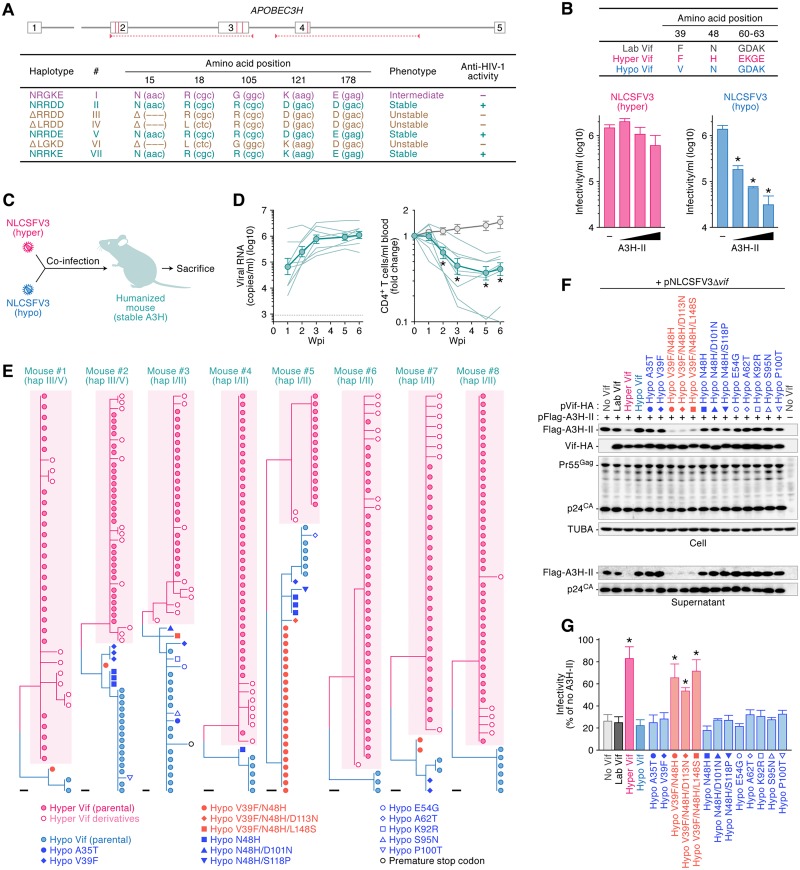
Dynamics of hyper/hypo HIV-1 infection in stable A3H humanized mice.(A) A schematic of the A3H gene locus and the 5 polymorphisms in A3H exons 2, 3, and 4 (indicated by red vertical lines) that combine to produce 7 different haplotypes. Red arrowheads with horizontal broken lines indicate the region amplified by genotyping PCR. In the bottom panel, the 7 different A3H haplotypes based on observed protein stability or instability in previous studies [14,15,20] are summarized. (B) (top) A schematic of the Vif protein encoded by HIV-1 used in this study. This panel shows the amino acid differences responsible for the degradation of stable A3H. (bottom) TZM-bl assay. The infectivity of released virions was determined by using TZM-bl cells. *P < 0.05 versus no A3H-II by Student's t test. The assay was performed in triplicate. The data represents average with SD. (C, D) HIV-1 infection in humanized mice. (C) A schematic of co-inoculation of hyper and hypo HIV-1s into stable A3H humanized mice. (D) Hyper and hypo viruses containing 2.5 ng of p24 antigen each (5 ng in total; n = 8) or RPMI1640 (n = 12; for mock infection) were inoculated into humanized mice. the amount of viral RNA in plasma (left) and the level of peripheral CD4+ T cells (CD45+ CD3+ CD4+ cells) (right) were analyzed at 0, 1, 2, 3, 5, and 6 wpi as described in Materials and Methods. The averages are shown in circles with SEMs, and the values from each mouse are shown by line. X-axes, wpi. In the left panel, horizontal broken line indicates detection limit (800 copies/ml plasma). In the right panel, *P < 0.05 versus mock-infected mice by Mann-Whitney U test. (E) Phylogenetic trees of vif sequence. Viral vif sequences in the plasma of infected mice at 6 wpi were analyzed as described in Materials and Methods. Results of each infected mouse (mice #1–8) are respectively shown. Each symbol represents identical sequence. Pink shadow indicates hyper vif derivatives. Scale bar represents one nucleotide substitution. Note that the 3 hypo vif-related sequences with the ability to counteract A3H-II (shown in Fig 1F & 1G) are indicated with red symbols. (F, G) Evaluation of anti-stable A3H activity of Vif derivatives detected in infected humanized mice. (F) Western blotting. The input of cell lysate was standardized to α-Tubulin (TUBA), and representative results are shown. (G) TZM-bl assay. The expression plasmids of the Vif derivatives were cotransfected with pNLCSFV3Δvif and either with or without Flag-tagged A3H-II expression plasmid into HEK293T cells. The infectivity of released virus was determined by using TZM-bl cells, and the percentage of the value of "no A3H-II" is shown. *P < 0.05 versus "no Vif" by Student's t test. The assay was performed in triplicate. The data represents average with SD. In panels F and G, the symbols are identical to those in Fig 1E.